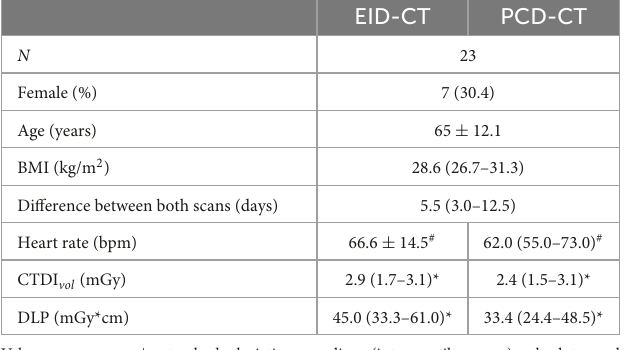
TABLE 2 Patient